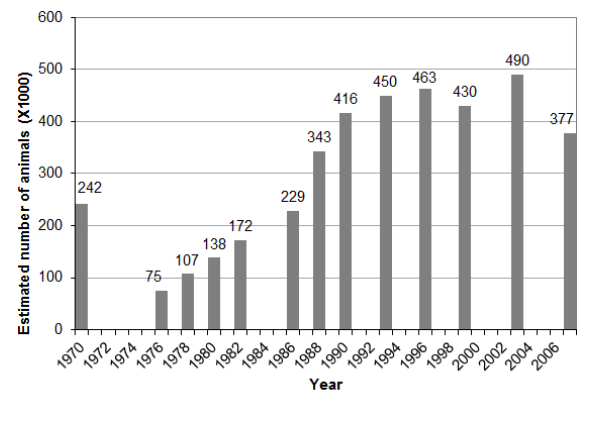
Fig. 2. Population estimates for the Western Arctic Caribou herd. Source: Western Arctic Caribou Herd Working Group (2003), Woodford